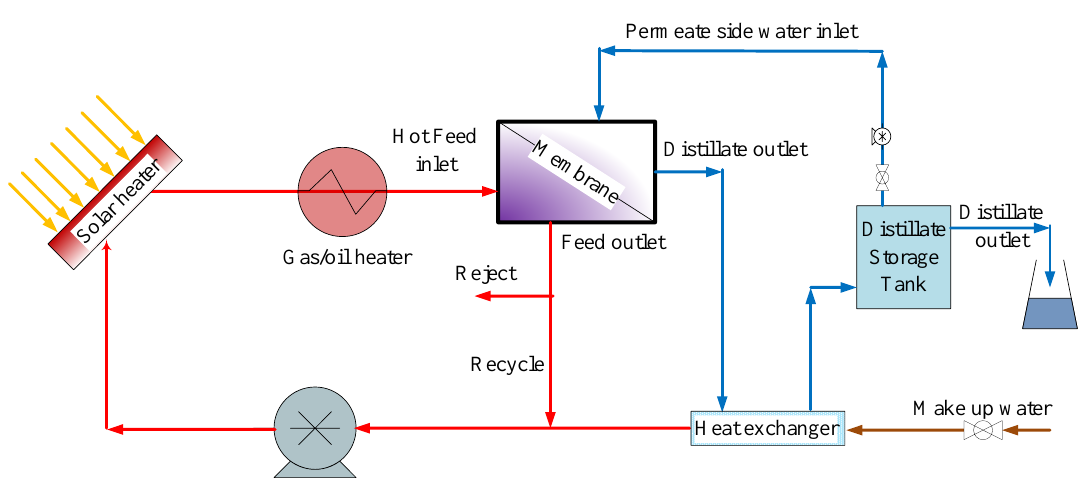
Figure 3. Schematic of solar heating assisted membrane distillation (MD) desalination.